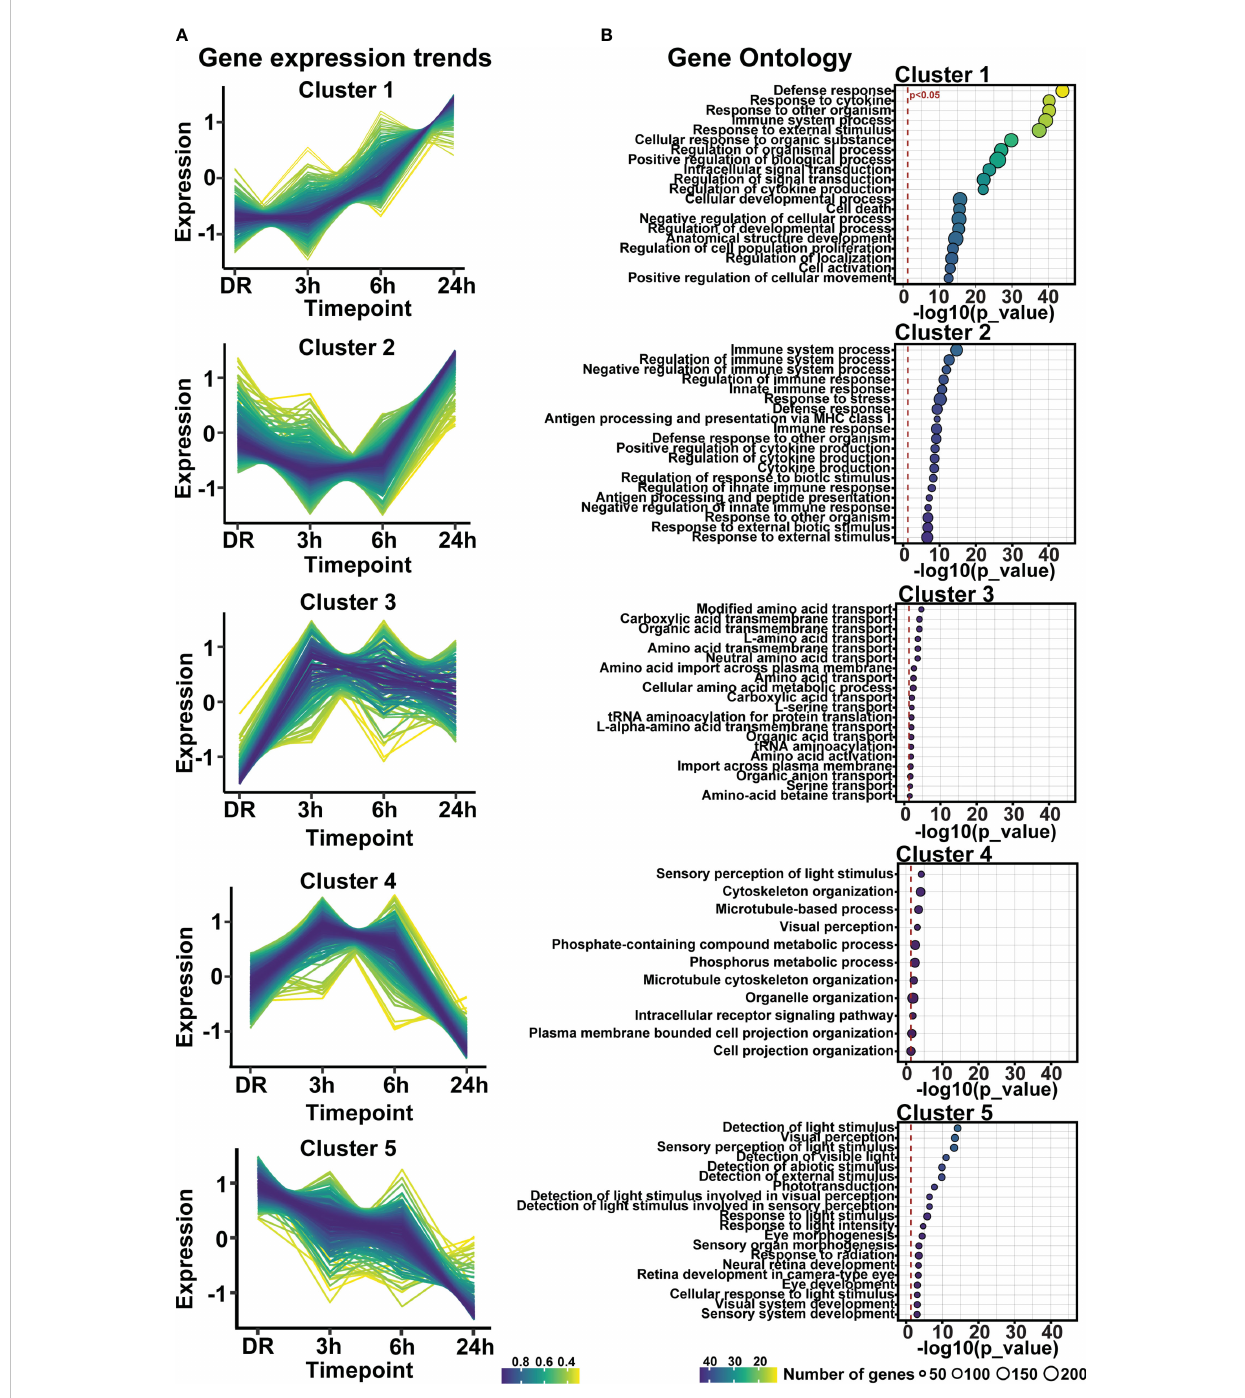
FIGURE 6 Gene expression pro fi les regulating in fl ammation, visual processing, metabolism, and amino-acid transport are altered in response to short exposure to photo-oxidative damage. (A) Fuzzy clustering analysis identi fi ed fi ve trends of differentially expressed genes across 24h-PD. (B) Gene ontology analysis of genes within each cluster identi fi ed biological processes of in fl ammation, amino-acid transport, metabolism, and visual processing. (A) Color scheme indicates membership of gene to each cluster, (B) Signi fi cance p < 0.05, circle size in relation to number of genes associated with each GO term.